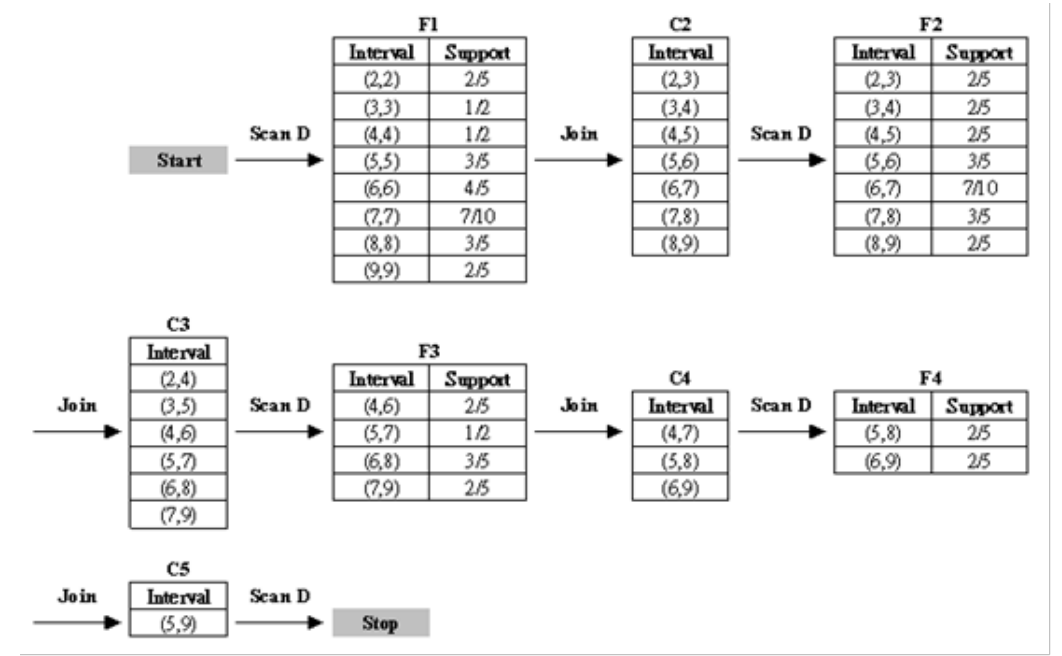
Fig. 5 Steps to find frequent intervals by using the Apriori-modified algorithm.